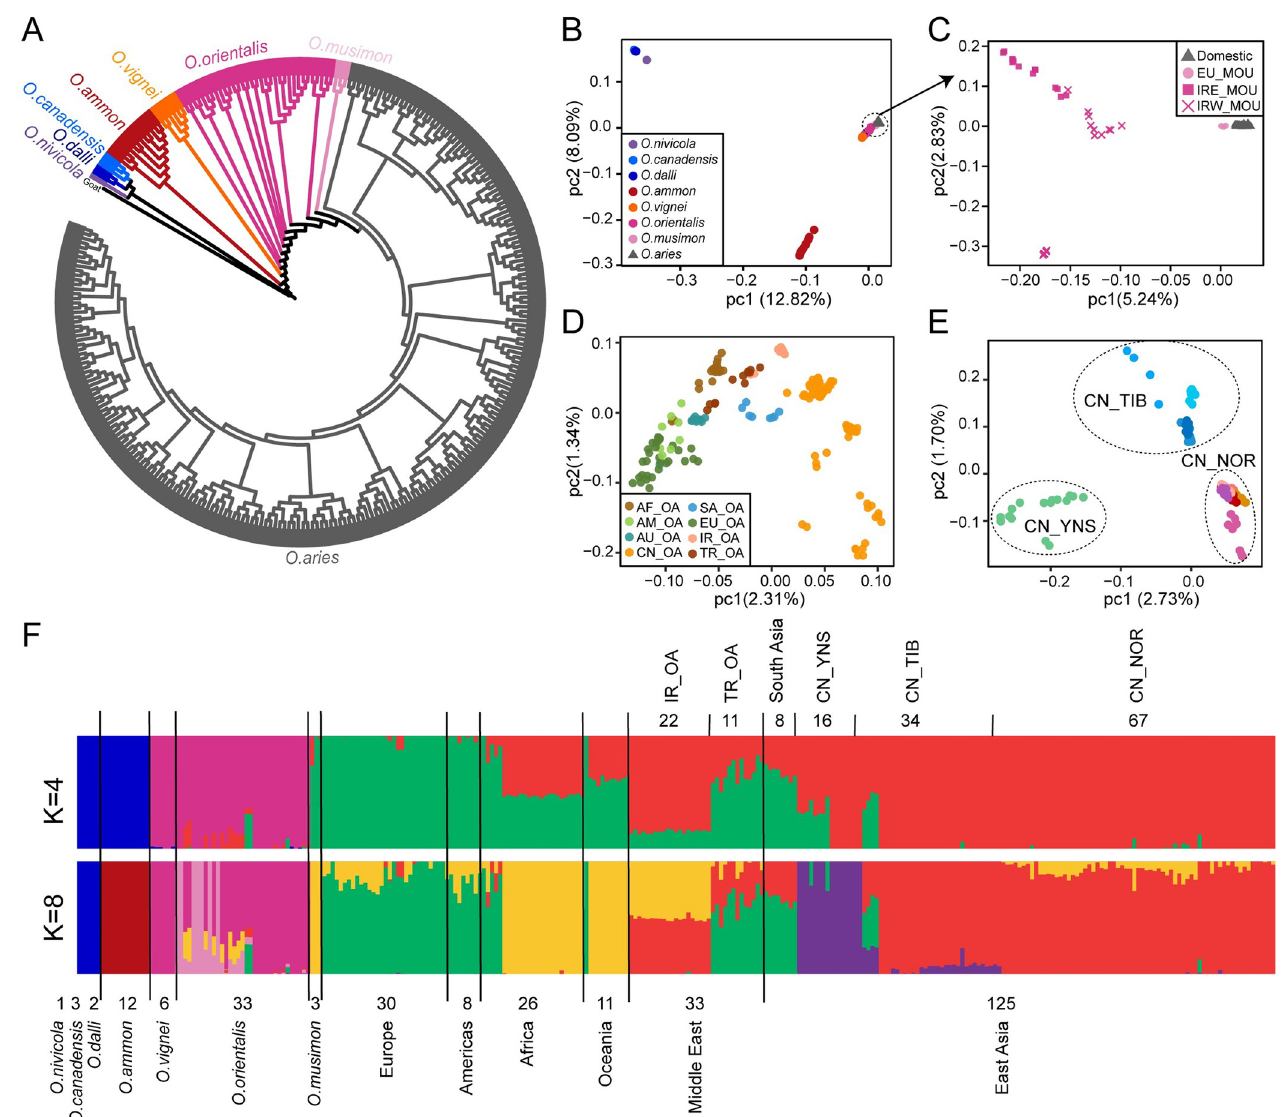
Fig 2. Phylogenetic analysis and population genetic structure. (A) A maximum likelihood (ML) phylogenetic tree of 293 representative samples covering all species of Ovis genus with Goat (GCA_000317765.2) as an outgroup. The tree was built with 100 bootstraps using a total of 332,990 4DV sites. (B-E) PCA analysis of wild and domestic sheep (B), Iranian and European mouflon and domestic sheep (C), domestic (D) and Chinese sheep (E), respectively. EU_MOU, European mouflon; IR-MOU, mouflon sheep from Iran. AF_OA, AM_OA, AU_OA, CN_OA, SA_OA, EU_OA, IR_OA, TR_OA, separately represent domestic sheep from Africa, America, Oceania, China, south Asia, Europe, Iran and Turkey. CN_TIB, CN_YNS, CN_NOR for domestic sheep from Tibet, Yunnan, Northern China. (F) ADMIXTURE results for k = 4 and k =